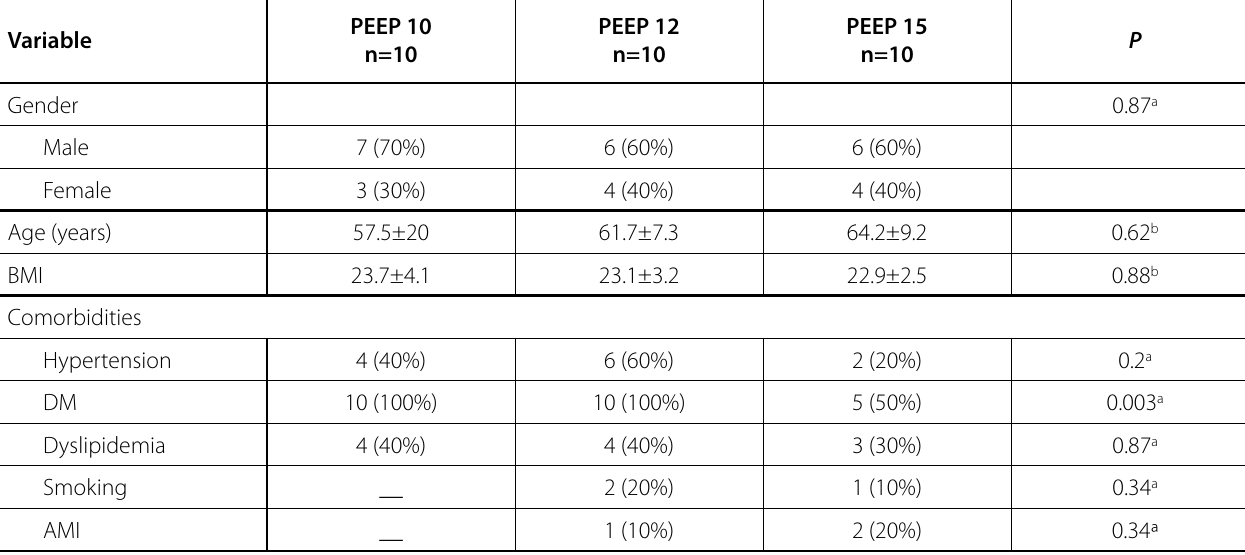
Table 1. Demographic characteristics of patients undergoing myocardial revascularization.